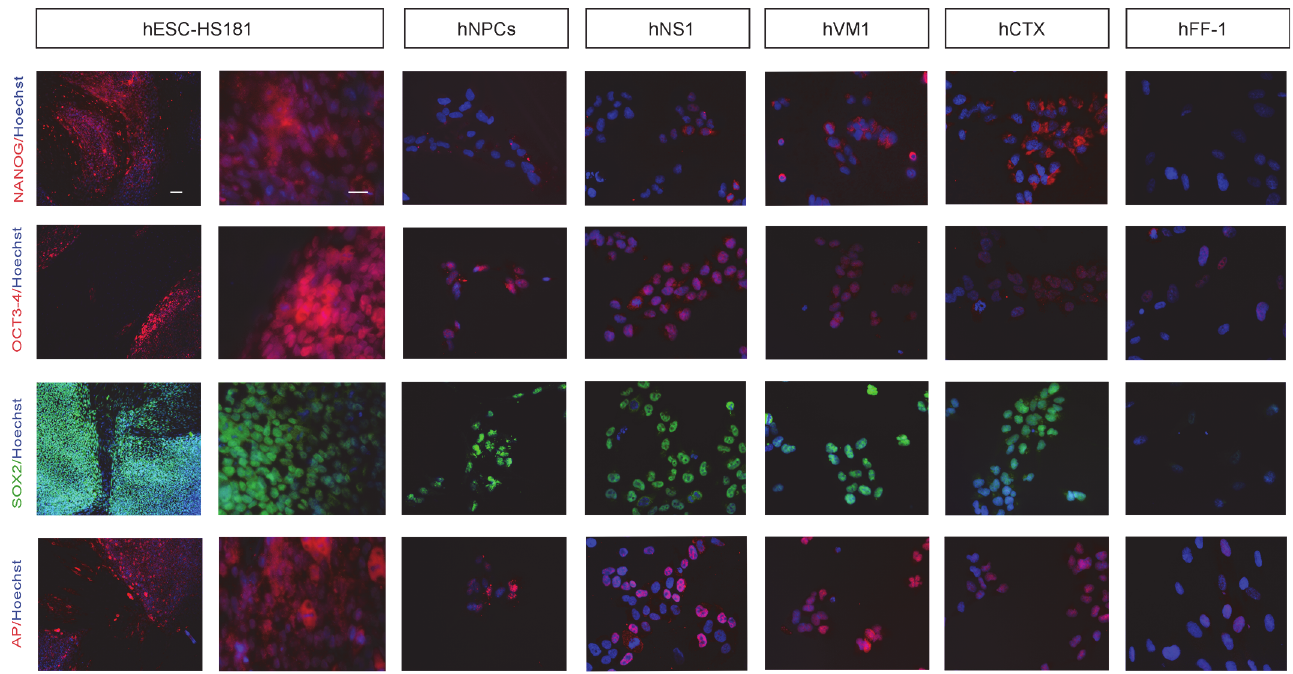
Fig 3. Immunocytochemistry of pluripotency markers. Staining was performed 48 hours following the last passage. From left to right: staining displayed by hESCs (HS181 line, low and high magnifications), hNPCs, v-myc immortalized lines (hNS1, hVM1, and hCTX) and fibroblasts (hFF-1). From top to bottom the markers studied were: NANOG, OCT3/4, SOX2 and AP. Hoechst 33258 nuclear staining is shown in blue. Scale bar represents 100 μ m for hESCs in the left hand column (low magnification) and 25 μ m for all the other microphotographs.